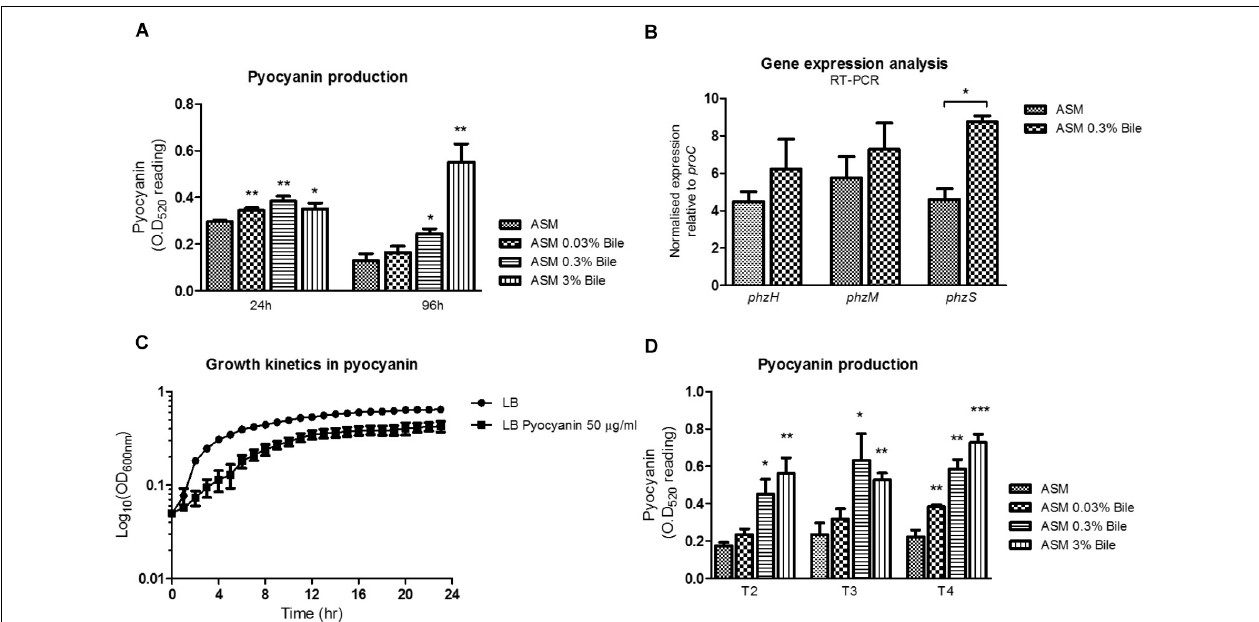
FIGURE 1 | (A) The phenazine PYO is elevated in ASM supplemented with a range of bile concentrations. (B) Enhanced PYO production is underpinned by increased phzS expression, the final step of the PYO biosynthetic pathway, as measured by RT-PCR analysis. No significant change in gene expression was observed for phzH or phzM , the two other central genes in PYO biosynthesis. (C) PYO, at a concentration of 50 µ g/mL reduces the growth rate and biomass of Pseudomonas aeruginosa. (D) Serially cycling P. aeruginosa in ASM supplemented with bile confirms the consistent up-regulation of PYO production over time. Data is the mean of at least three independent biological replicates. Statistical analysis was performed by Student’s t -test ( ∗ p ≤ 0.05; ∗∗ p ≤ 0.01; ∗∗∗ p ≤